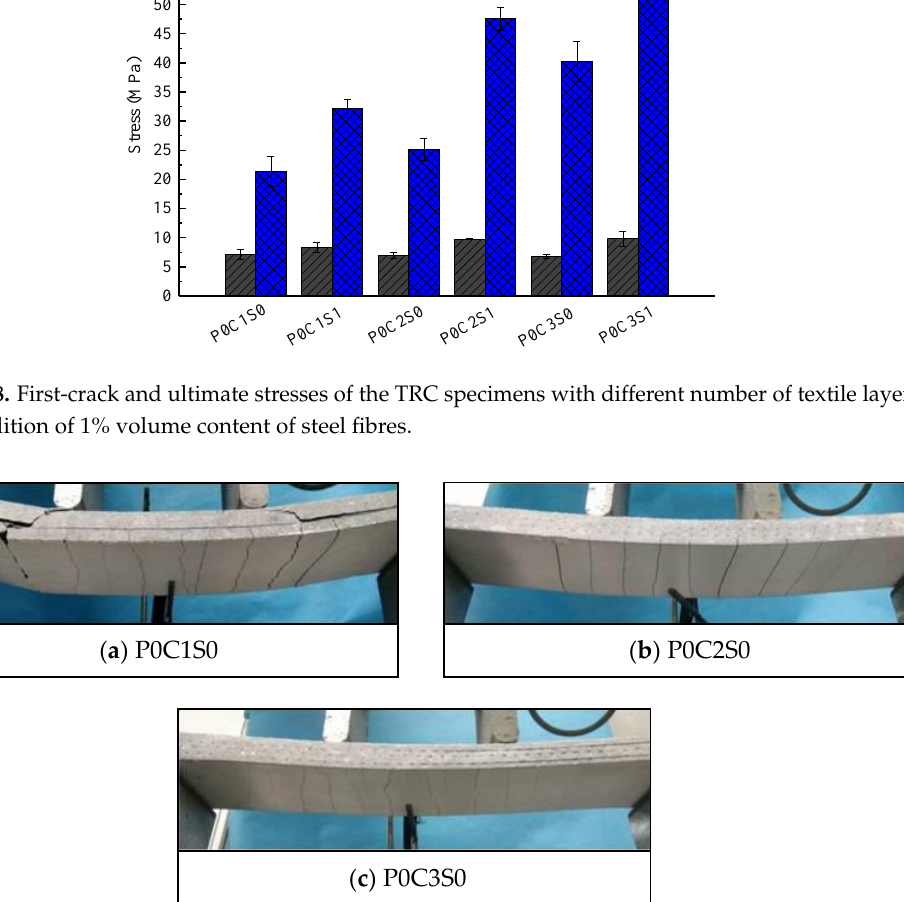
Figure 9. Crack patterns of the TRC specimens with different number of textile layers.